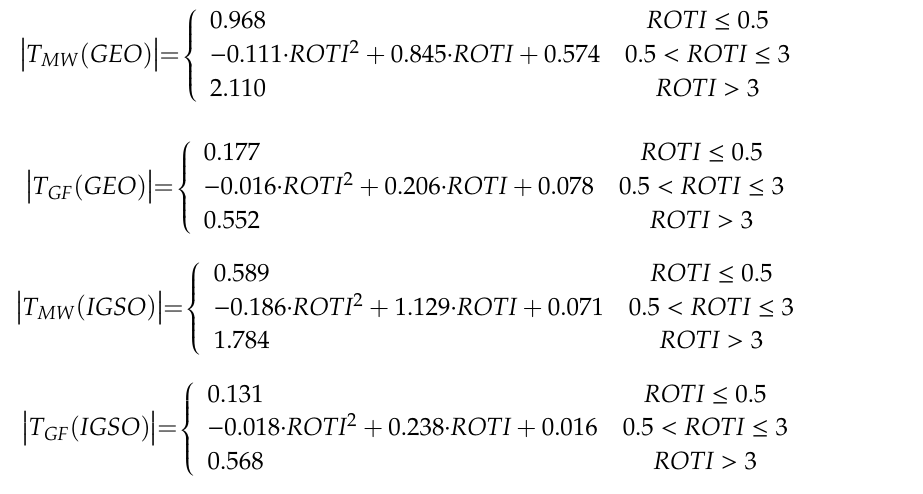
1.025 TECU/min based on one-year BDS dataset from HKST. 0.975 < ROTI ≤ 1.025 TECU / min based on one-year BDS dataset from